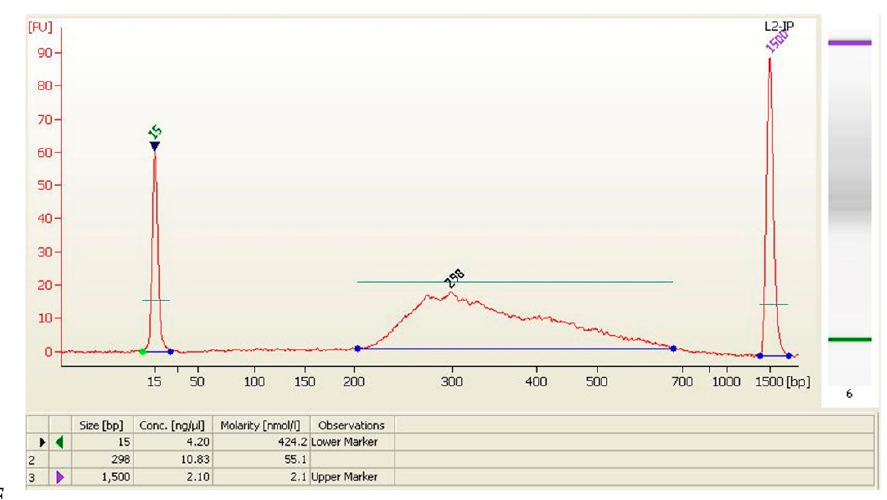
Figure 2. Quality evaluation of control and LB groups by sequencing library. Two samples from the LB group and two samples from the control group were selected (L1, L2, C1, C2). ( A ) C-Input; ( B ) C1-IP;